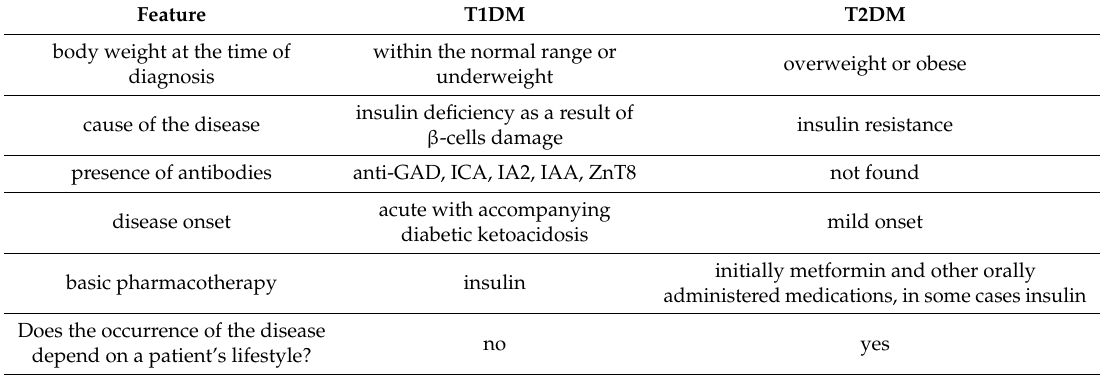
Table 1. Comparison of type 1 and type 2 diabetes